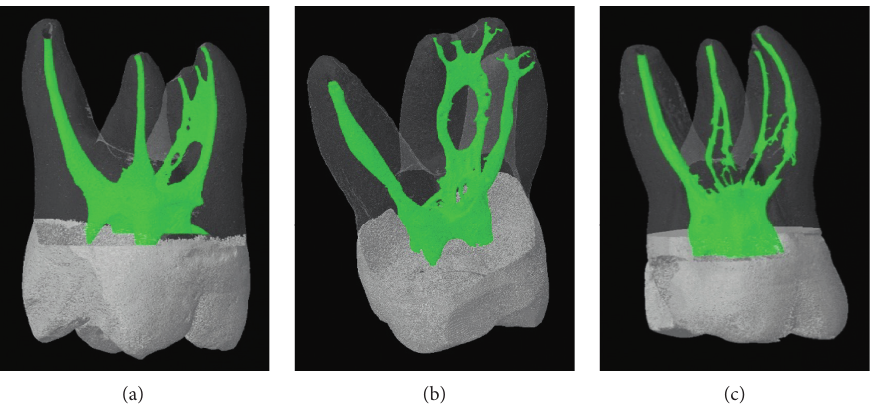
Figure 2: Burmese maxillary first molars with Vertucci’s type IV canal in the mesiobuccal root. (a) Mesiobuccal root shows Vertucci’s type IV canal, while distobuccal and palatal roots show Vertucci’s type I canal. A sheet complete isthmus with a lateral canal was seen at the middle and apical third of the mesiobuccal root. (b) Mesiobuccal root shows Vertucci’s type IV canal with sheet complete isthmuses at the apical and coronal third. A lateral canal was originating from the isthmus in the apical third of the mesiobuccal root. Distobuccal and palatal roots show Vertucci’s type I canal. (c) Mesiobuccal root shows Vertucci’s type IV canal with a mixed complete isthmus at the middle third, and distobuccal root discloses Vertucci’s type II canal with a tube complete isthmus at the middle third. Palatal root shows Vertucci’s type I canal.